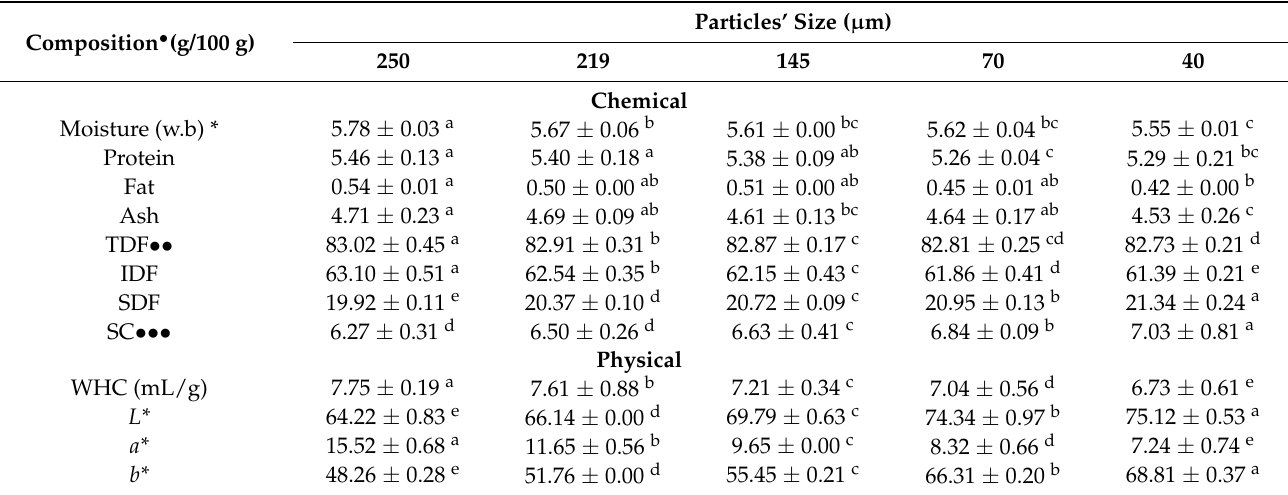
Table 2. Proximate composition, water holding capacity (WHC), and color attributes of alcohol insoluble residue from potato peel byproduct (AIR-PPB) at different particle sizes